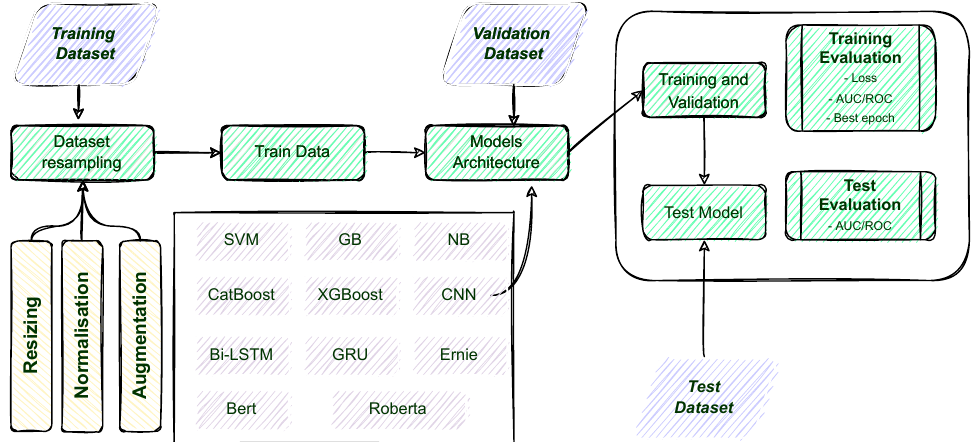
Figure 4. Graphical representation of the pipeline stages for training and testing for ML, DL, and transformer